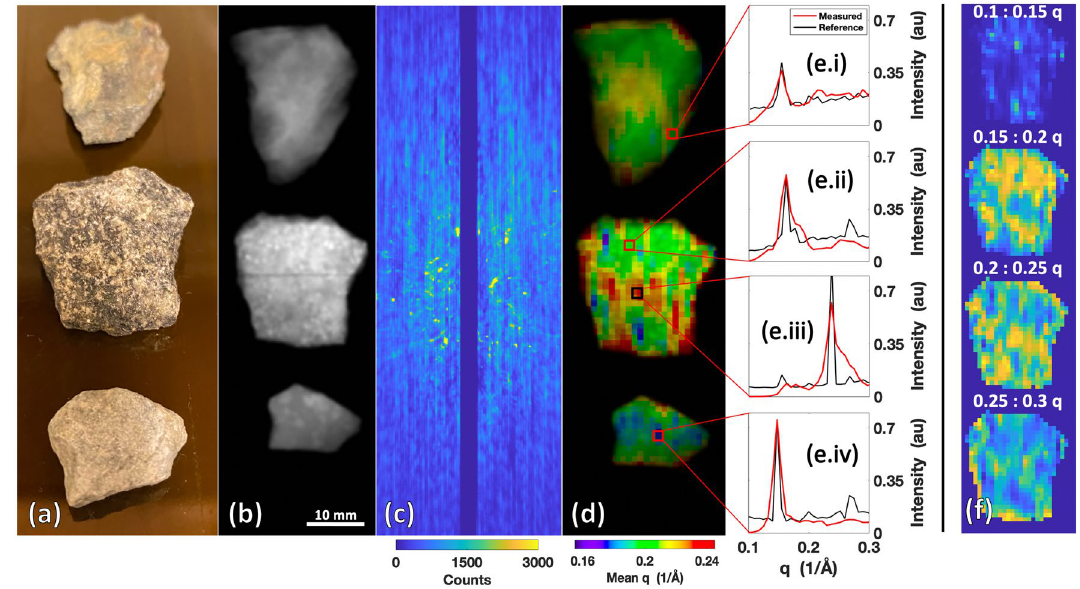
Figure 4. Rock specimens scanned by the X-ray fan beam coded aperture imaging system. ( a ) Photograph of the fieldstone (top), asphalt (middle), and limestone (bottom). ( b ) Transmission scan of the rock specimens. ( c ) Raw multiplexed scatter data from central fan slice showing the textured signal from the rocks. ( d ) Combined transmission + q colorization (TQC) image of the rocks showing new spatial variations relative to transmission alone. ( e . i – iv ) XRD spectra extracted from the marked locations in ( d ), compared against commercial diffractometer measurements of the rock specimens. ( f ) Hyperspectral display of the asphalt rock (selected due to its higher XRD spatial variation) over distinct q